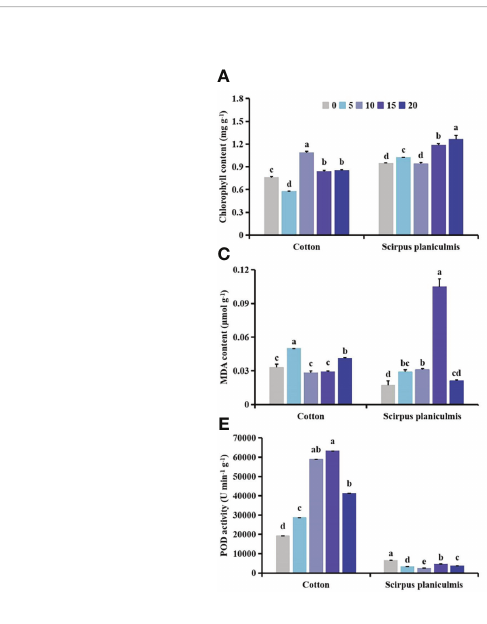
FIGURE 13 Effects of spraying 0.015 g L -1 75% tri fl oxysulfuron + 4 g L -1 40% prometryn on (A) chlorophyll, (B) soluble protein and (C) malondialdehyde (MDA) content, and (D) superoxide dismutase (SOD), (E) peroxidase (POD) and (F) catalase (CAT) activities in cotton and Scirpus planiculmis . The mean value ± standard data were presented in the fi gure. Different alphabetical letters indicate the signi fi cant differences between different distances ( p <0.05).